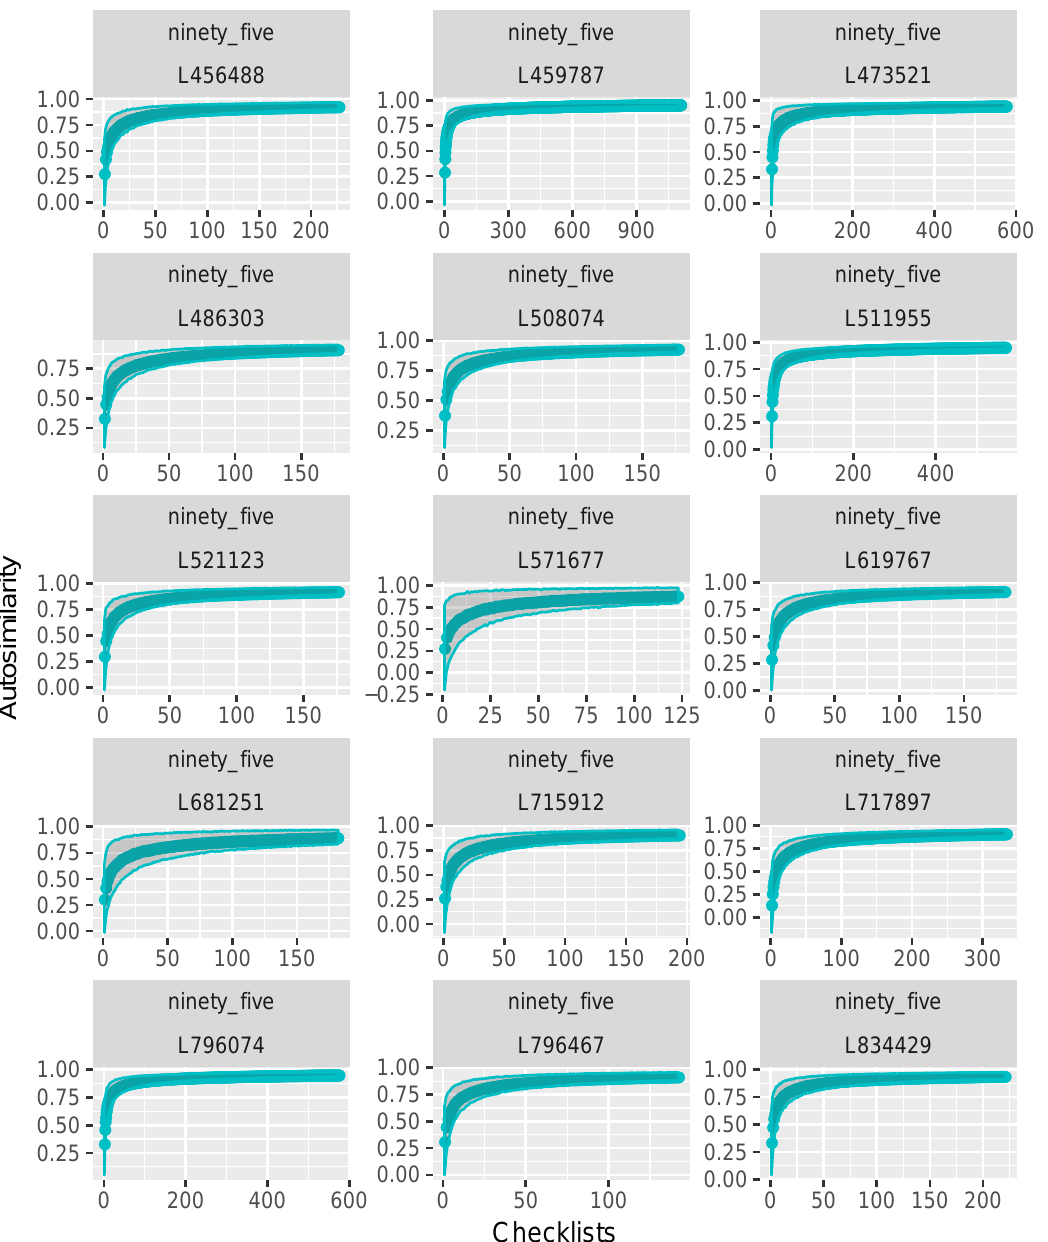
Figure. A4.3. Community composition (Bray-Curtis autosimilarity) accumulation curves for each of 30 North American greenspaces, presented for both